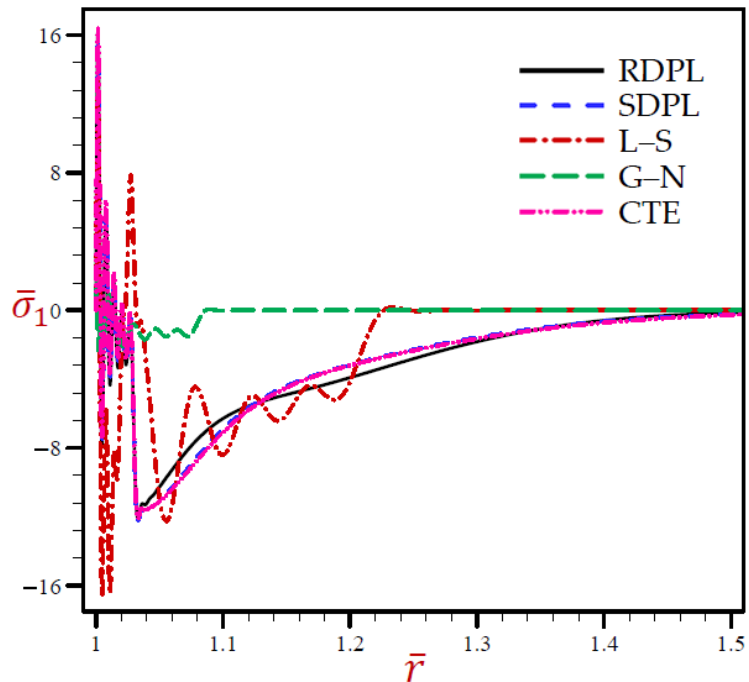
Figure 5. The radial stress 𝜎(cid:3364)